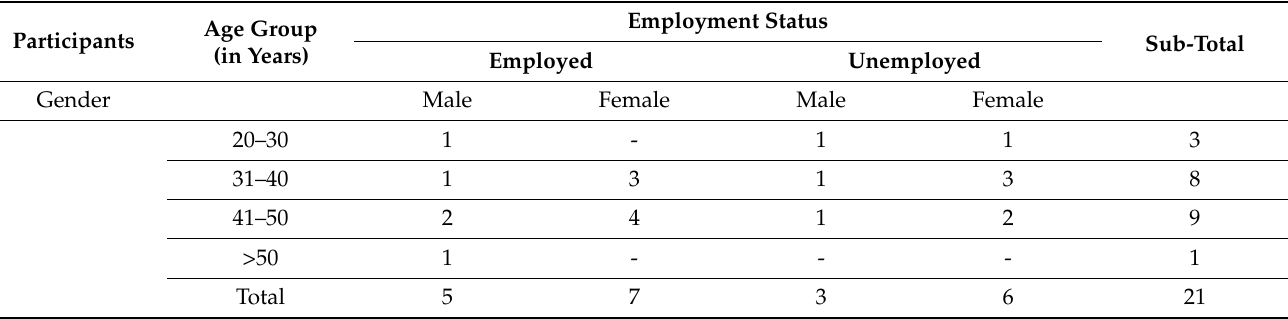
Table 1. Demographic characteristics of participants.